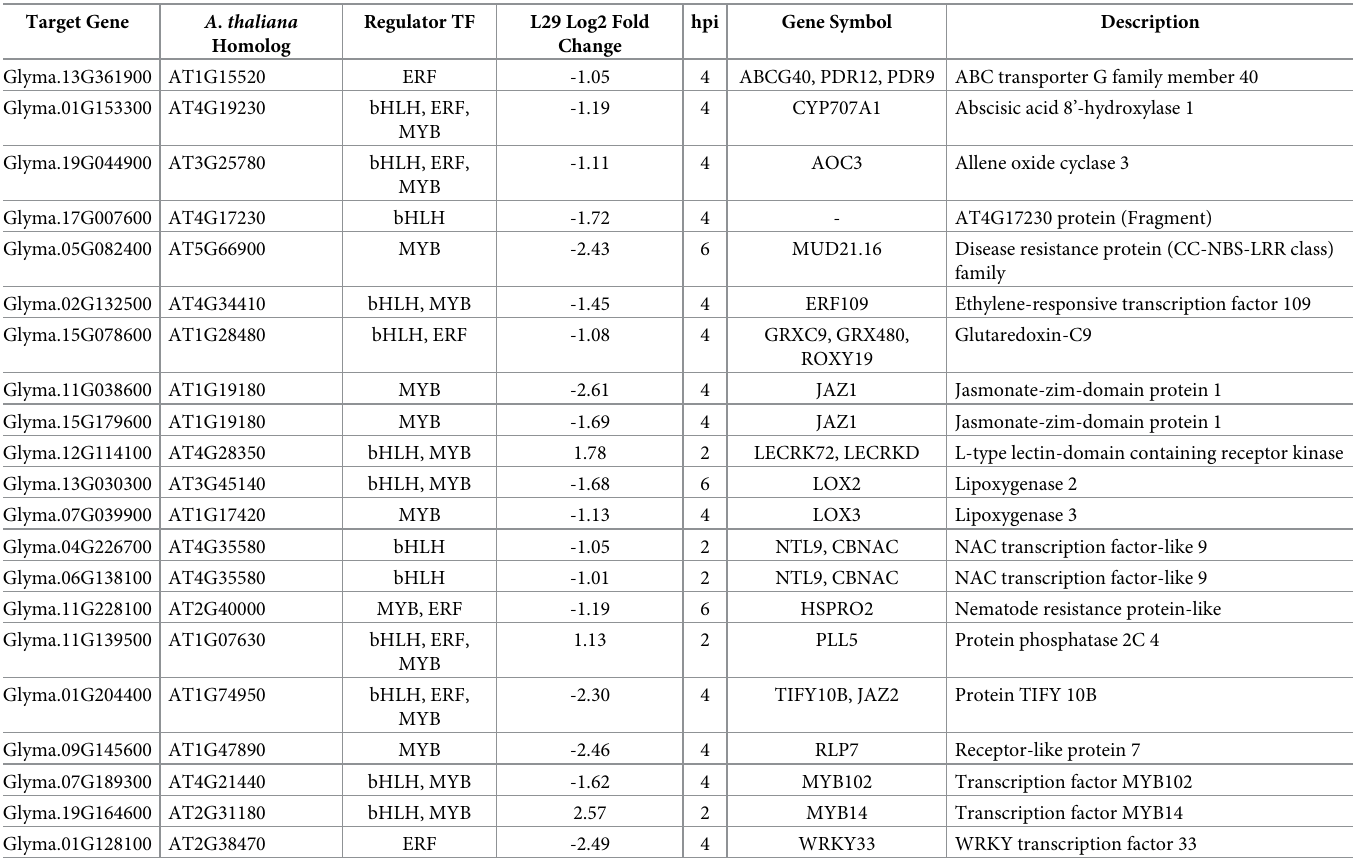
Table 3. TF target genes in module-4 related to JA processes and defense